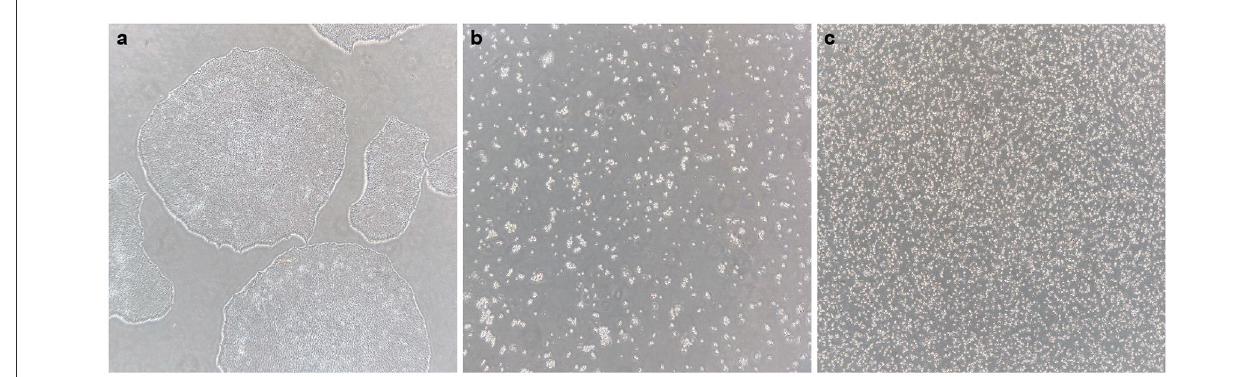
FIGURE2 Generating a single-cell iPS suspension. (a) Healthy iPS colonies at 70–80% confluency, without signs of differentiation. (b) After 0.5mM EDTA incubation and subsequent incubation with accutase, all cells have dissociated into single cells or small groups of cells, and all cells are floating. (c) After gentle trituration of the dissociated cell suspension, a pure single-cell suspension is